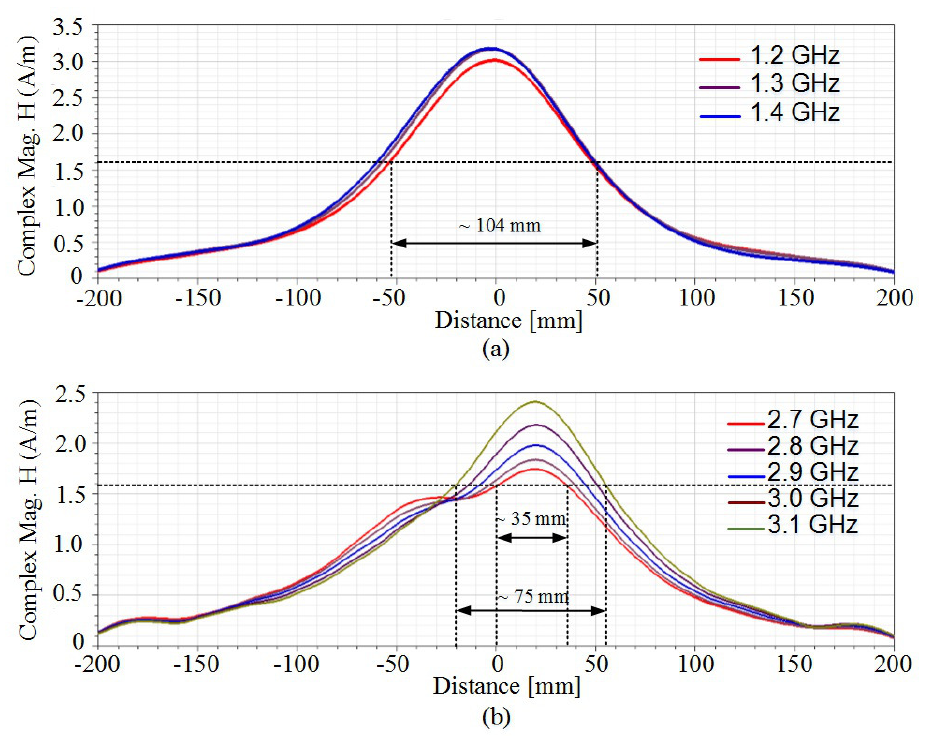
Figure 12. Simulated H-field intensity on the metal surface at the center cross section of the steel plate with input power of 15 W ( a ) Field levels for 1.2–1.4 GHz range, ( b ) Field levels for 2.7–3.1 GHz